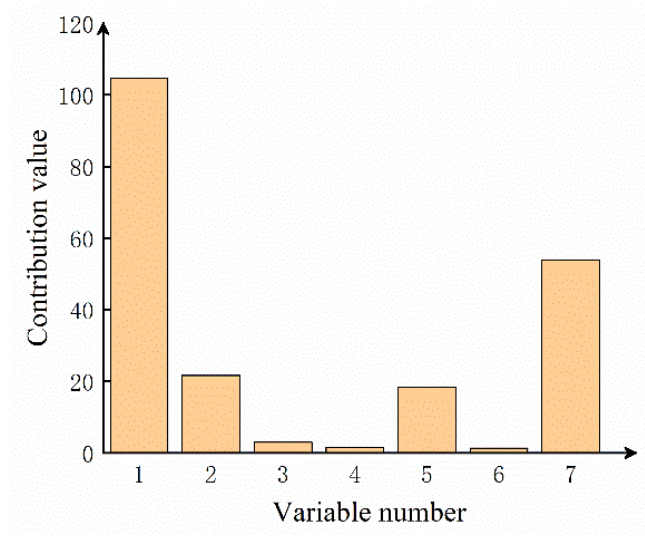
Figure 20. Relative contribution plot of sample 2.